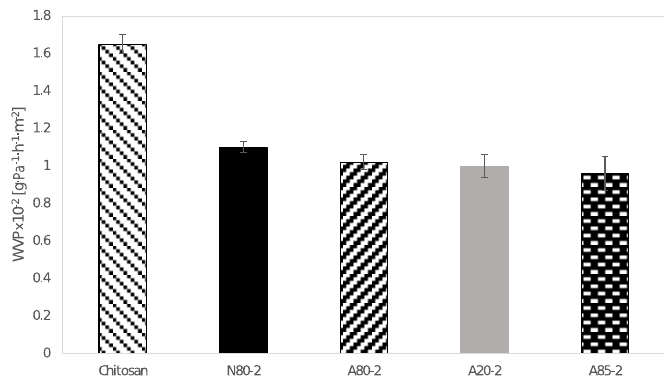
Figure 4. Water vapor permeability (WVP) of chitosan films without and with 2 wt.% thyme essential oil and emulsifier (TEO).